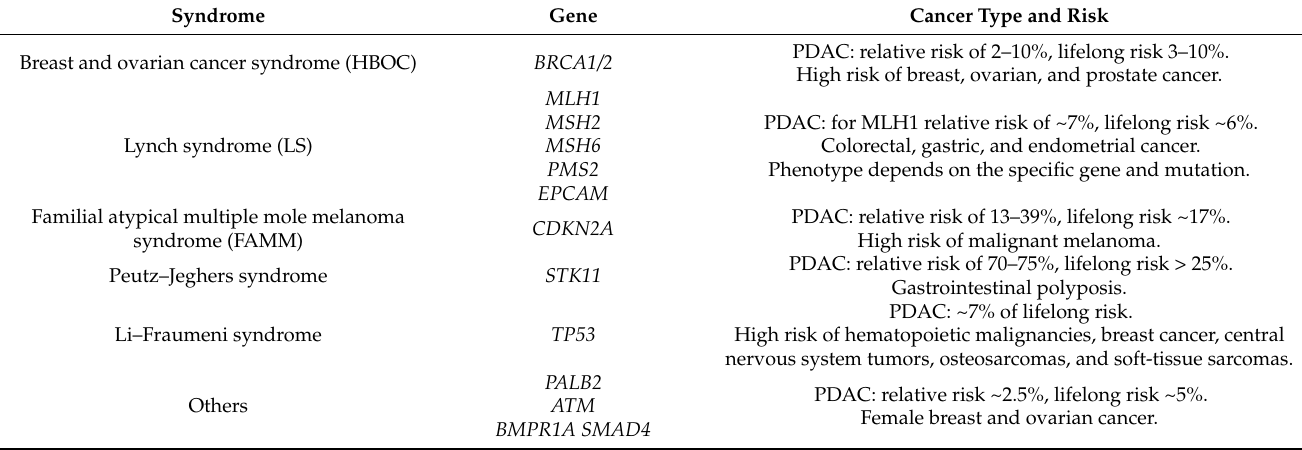
Table 1. Hereditary syndromes predisposing to pancreatic ductal adenocarcinoma [15,17]. Syndrome Gene Cancer Type and Risk